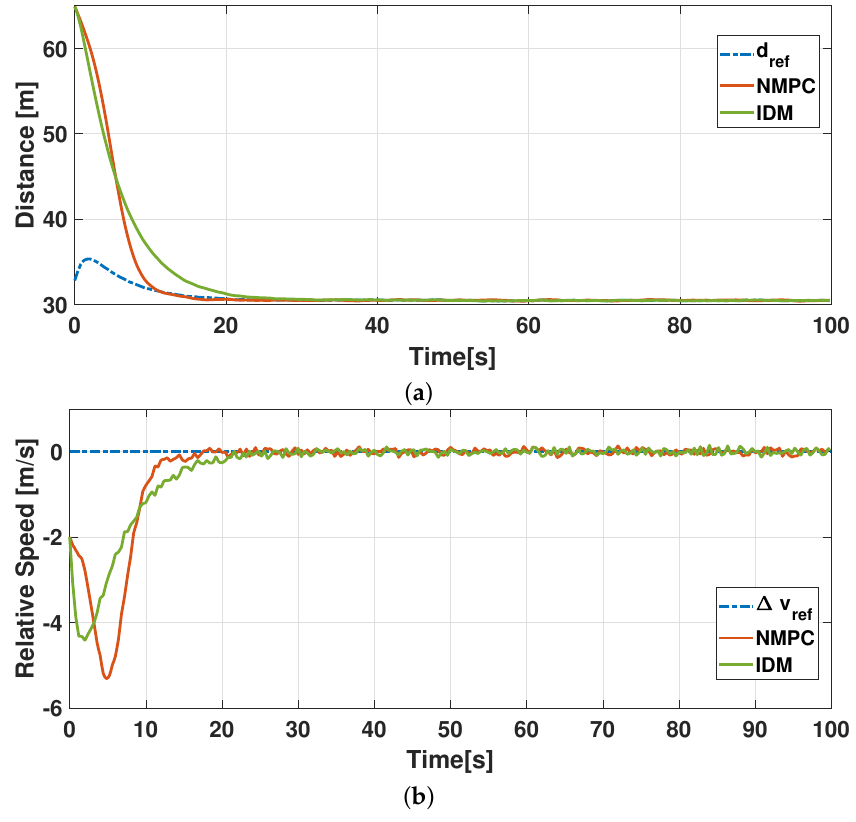
Figure 5. Single lane changing scenario . Performance of the proposed solution until the time instant t = 100 [ s ] and comparison analysis w.r.t. IDM solution. Time-history of: ( a ) relative distance d ( t ) between the Ego vehicle and the leading one; ( b ) relative speed ∆ v ( t ) between the ego and leading vehicles.